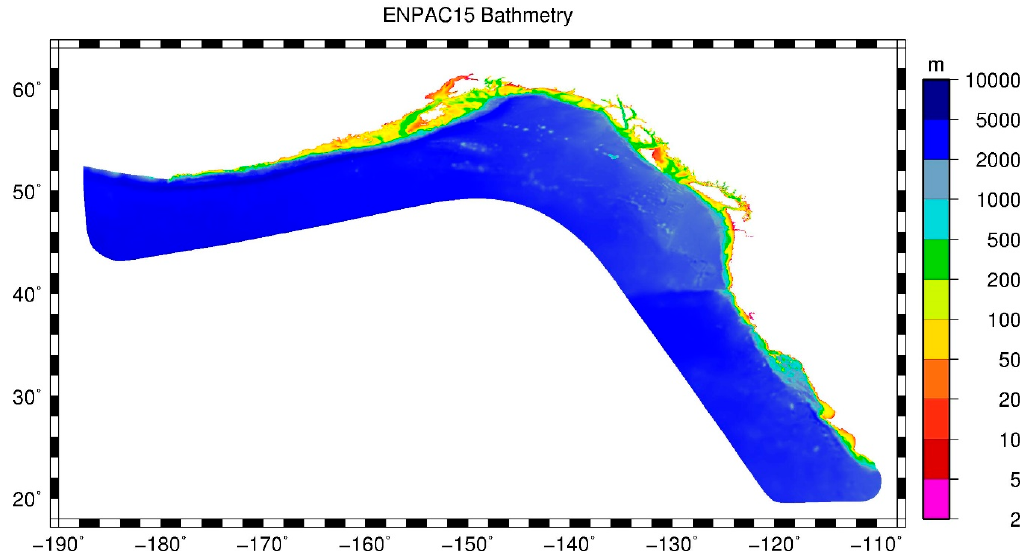
Figure 5. Bathymetry contours for ENPAC15 model.